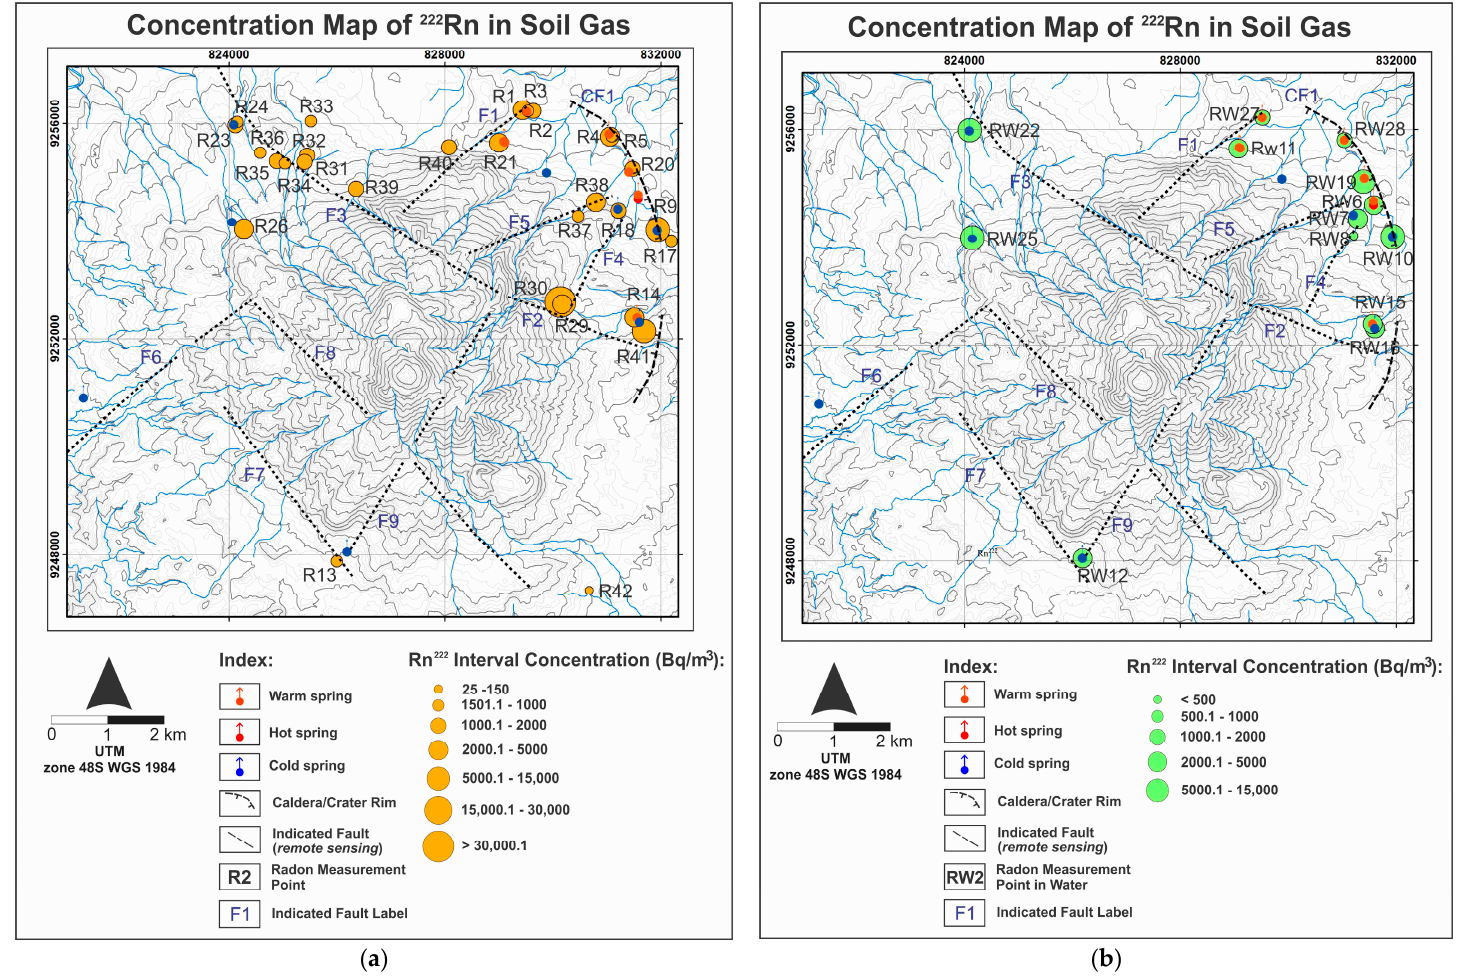
Figure 14. ( a ) 222 Rn concentration map for soil-gas. ( b ) Dissolved 222 Rn concentration map for water.